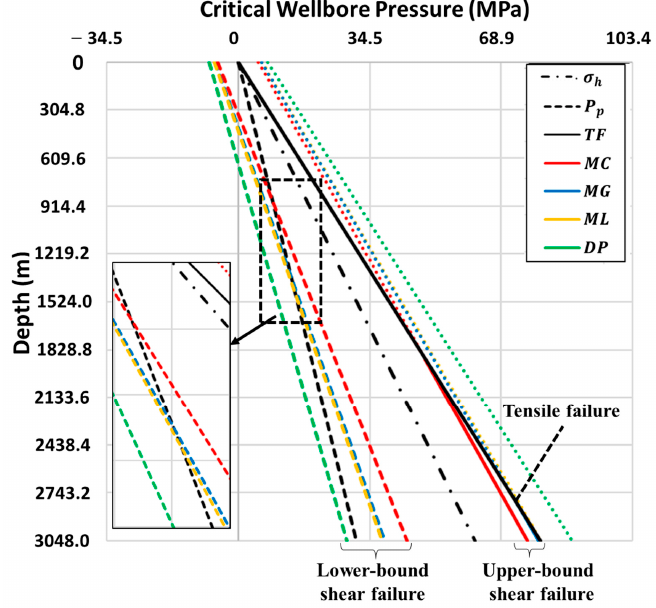
Figure 4. Strike-slip regime—strike-slip basin. Critical wellbore pressure at lower- (colored dashed), upper-bound shear (colored solid), and tensile (TF; black solid) failures under the strike-slip regime with the vertical, maximum and minimum horizontal stress gradients of 22.6, 24.9, and 20.4 kPa/m, respectively. The pore pressure gradient is 10.2 kPa/m (black dashed). The wellbore pressures were calculated by the Mohr–Coulomb (MC; red), Mogi–Coulomb (MG; blue), modified Lade (ML; yellow), and Drucker–Prager (DP; green) failure criteria. The minimum horizontal in-situ stress is depicted with the dash-dotted black line. The magnified frame indicates that the calculated lower critical wellbore pressures exceed the pore pressure at certain depths.